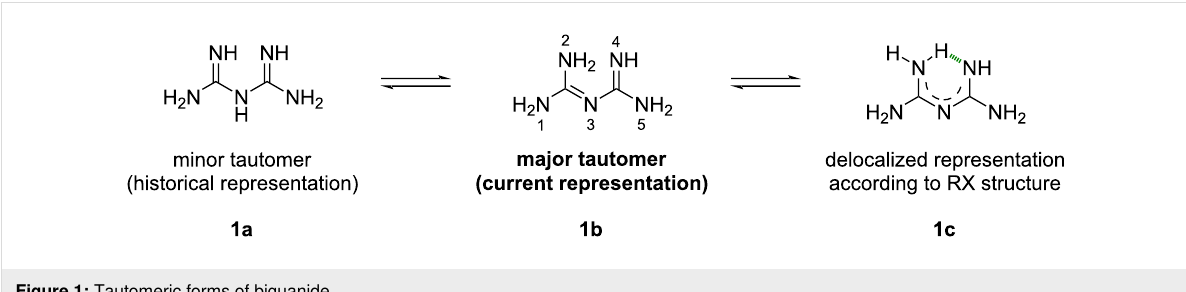
Figure 1: Tautomeric forms of